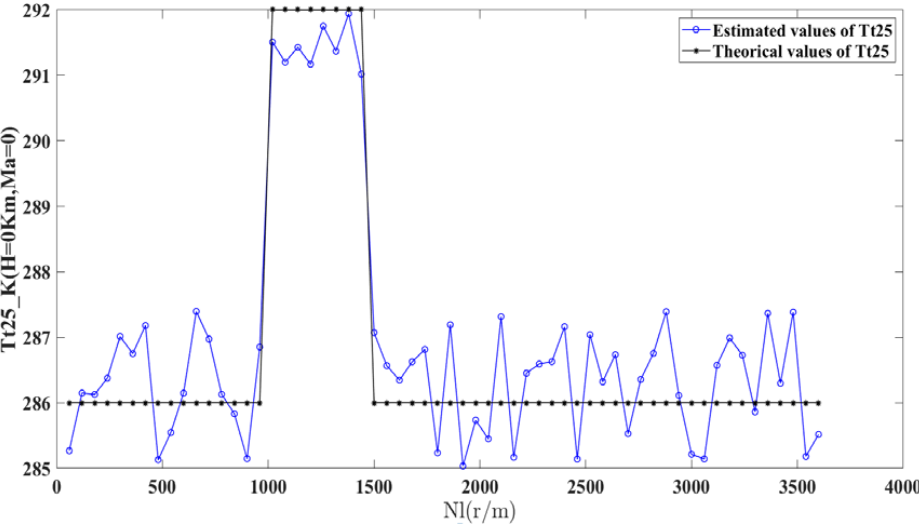
Figure 5. Estimations of T t25 by the strong tracking filter (STF).